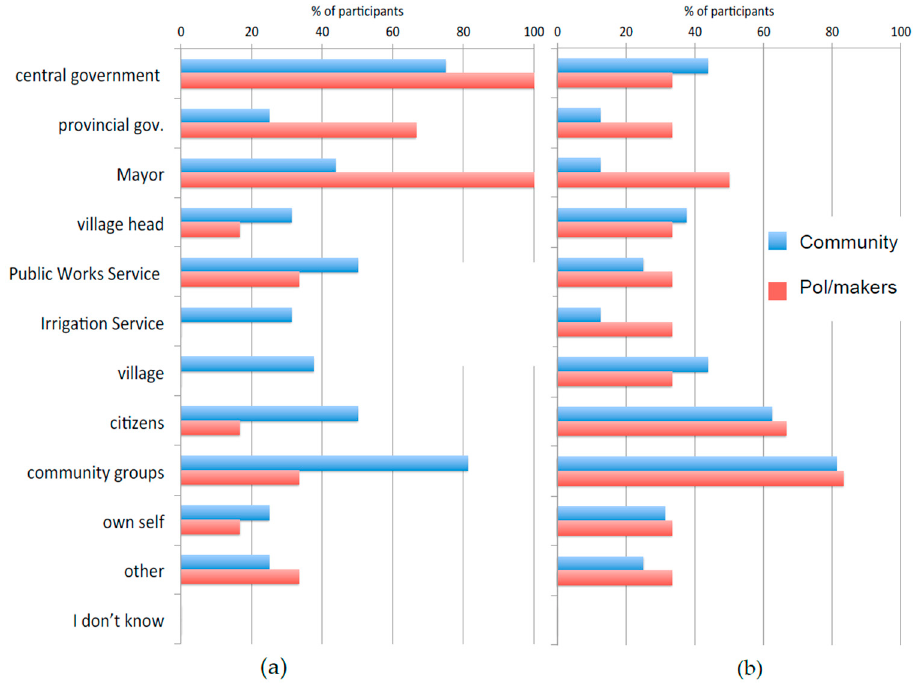
Figure 8. Comparison of community and policymaker responses to ( a ) who has the capacity to be a BGI champion and ( b ) who should take supporting roles?